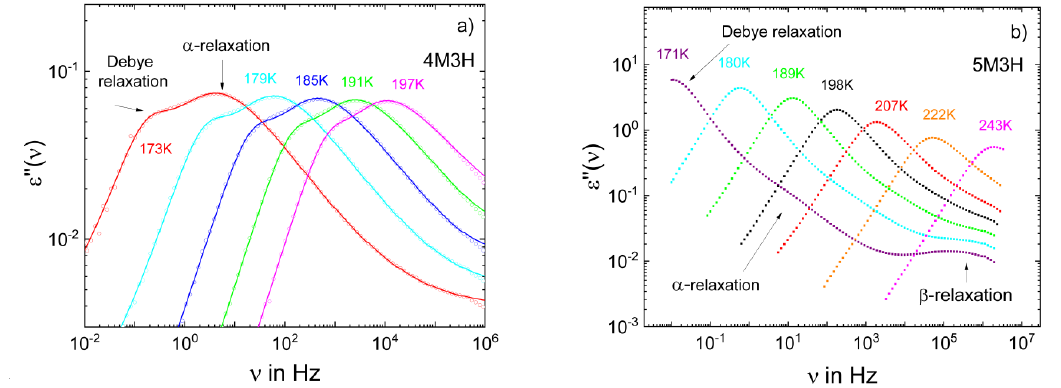
Figure 9. The dielectric spectra of ( a ) 4-methyl-3-heptanol (4M3H) and ( b ) 5-methyl-3-heptanol (5M3H). The spectra of 4M3H are fitted by a sum of a Debye and a Havriliak – Negami function.